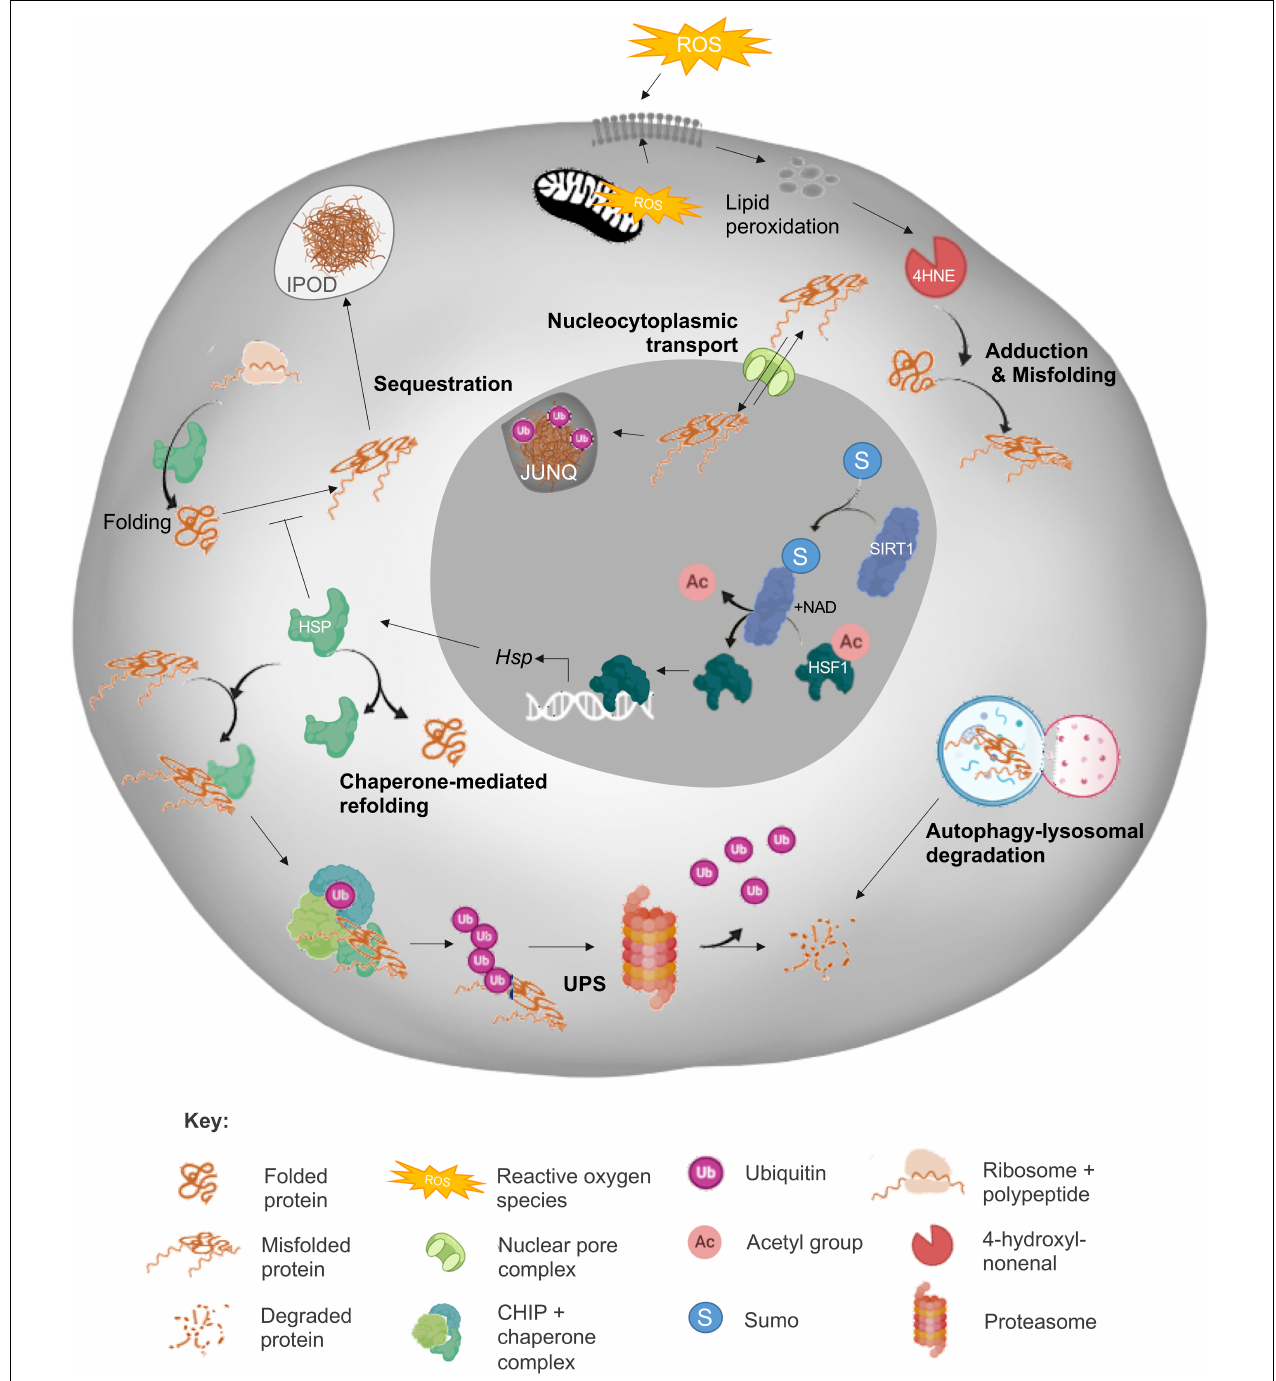
FIGURE 1 | Summary of the cellular proteostasis network. The fate of misfolded proteins arising from oxidative stress (ROS)-induced cascades varies depending on the nature of the protein and extent of damage. As depicted, adduction by reactive carbonyl species (RCS) such as 4-hydroxynonenal (4HNE) can elicit protein misfolding and necessitate the engagement of a panoply of cellular defense mechanisms designed to prevent propagation of protein damage and/or directly eliminate misfolded proteins. Among these mechanisms, the sensing of redox state and subsequent induction of heat shock response (HSR) by sirtuins (SIRT) leads to the upregulation of heat shock protein (Hsp) expression. The HSPs, or chaperone proteins are capable of directing misfolded targets toward pathways of protein refolding or targeted degradation via the ubiquitin-proteasomal pathway (UPS). As a more direct, but less selective route of degradation, misfolded proteins can also be recycled via autophagy/lysosomal machinery. Alternatively, misfolded proteins can be compartmentalized into insoluble protein deposits (IPOD) or sequestered into juxtanuclear quality control compartments (JUNQs) via shuttling between the cytoplasm and nucleus directed by nucleocytoplasmic transport machinery. Elements of this figure were made in